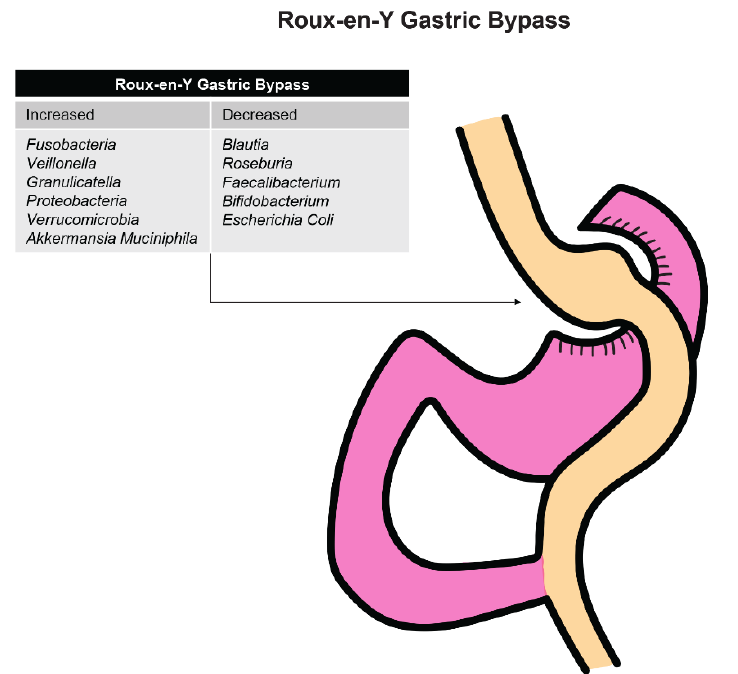
Figure 3. Effects of Roux-en-Y gastric bypass on organism levels in the stomach.